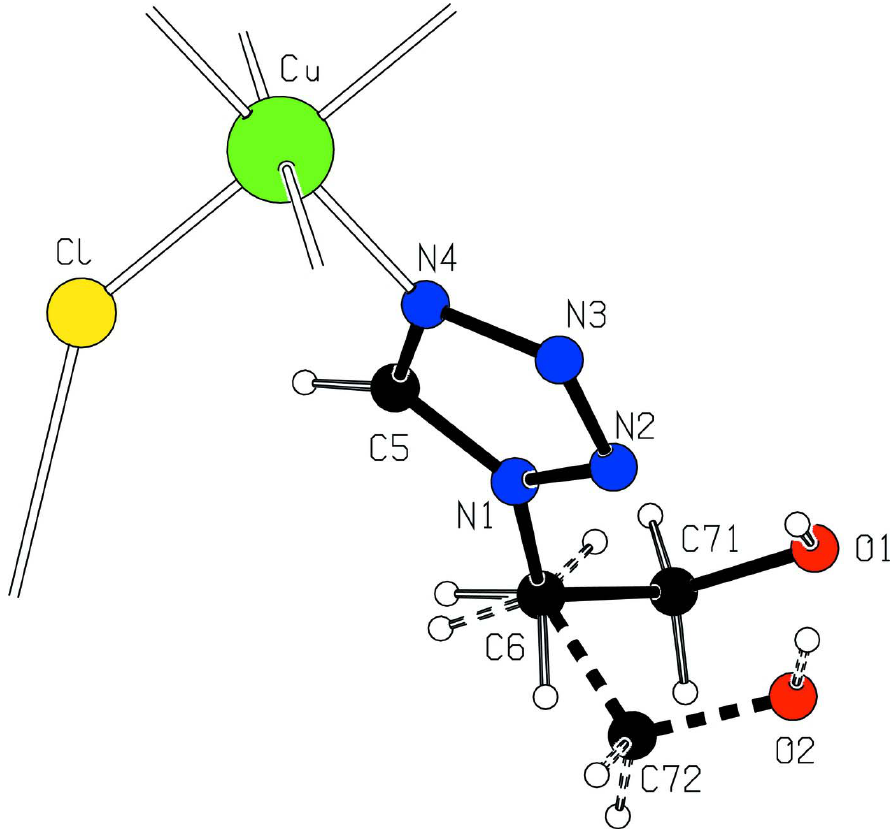
Figure 1 The asymmetric unit of (I) with the atomic numbering scheme. 2-hydroxyethyl substituent is shown as disordered over two